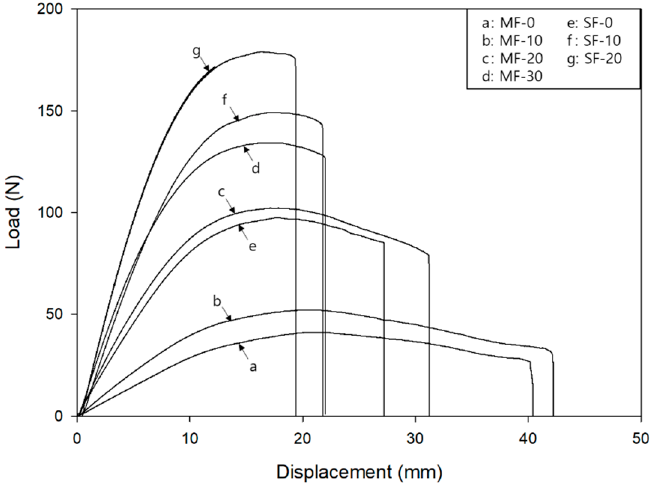
Figure 10. Load versus displacement curves measured with the MF-NiCF/PA6 (a–d) and SF- NiCF/PA6 (e–g) composites with various NiCF contents.